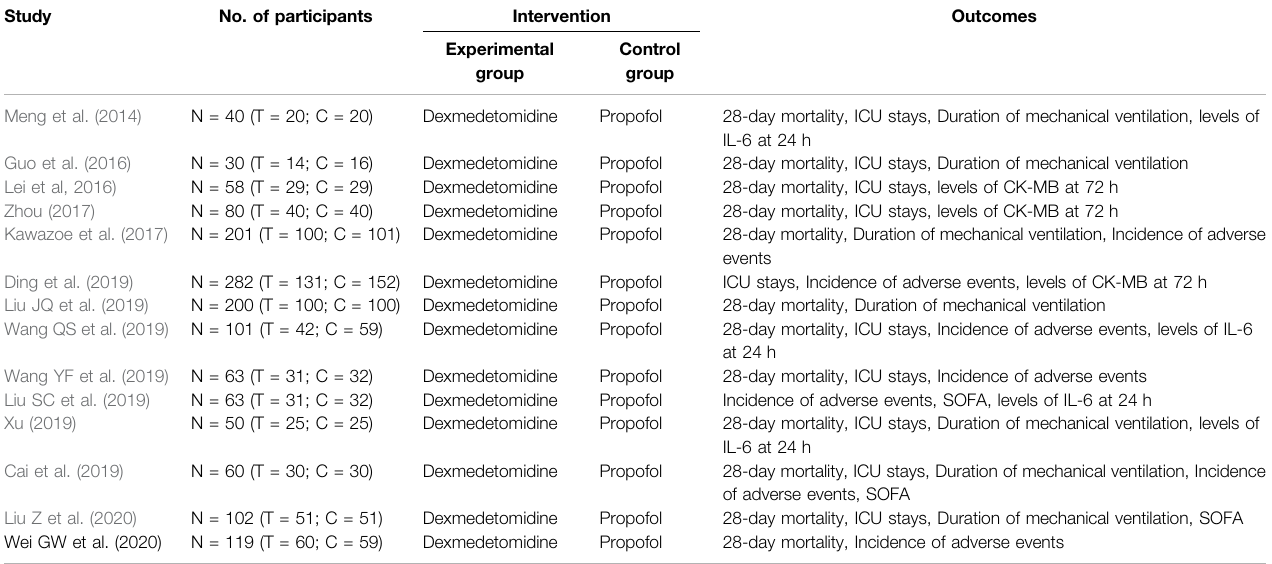
TABLE 1 | The characteristics of the included studies.